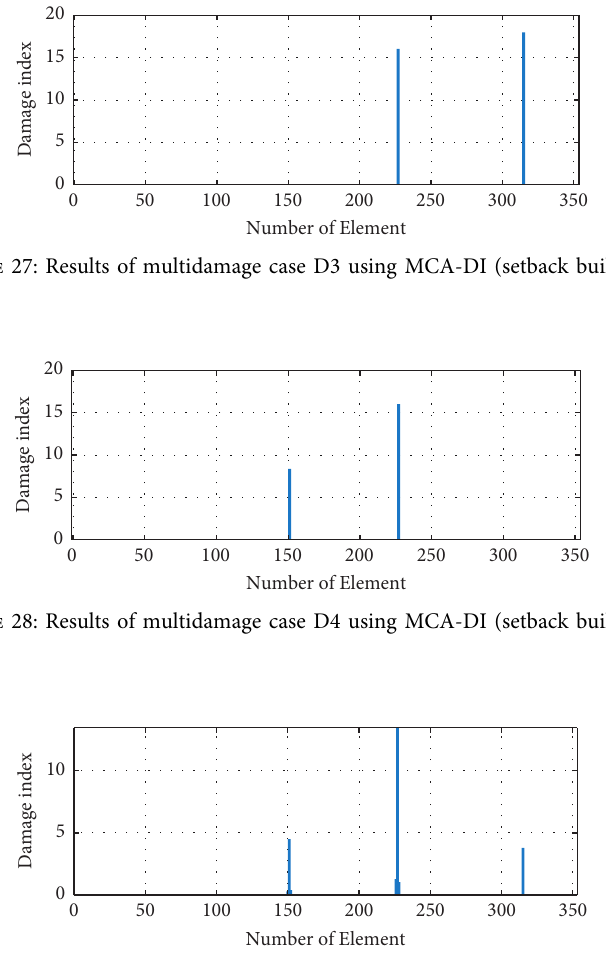
Figure 29: Results of multidamage case D5 using MCA-DI (setback